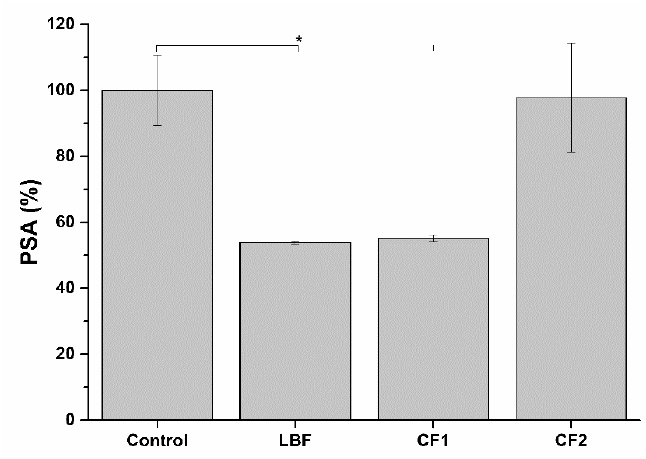
Figure 19. PSA secretion in LNCaP prostatic cells treated with bio-accessible fraction of the different formulations. * p < 0.05 ( n = 3).